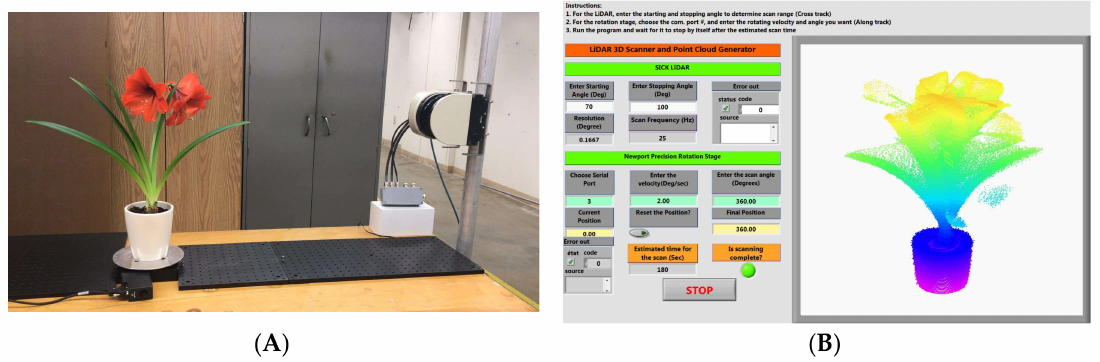
Figure 1. Illustration of the new instrument consisting of a LiDAR scanner and precision rotation stage for 3D measurement of plants at 360 ◦ view ( A ). The LabVIEW graphic user interface for instrument control, measurement acquisition, and real-time point cloud visualization ( B